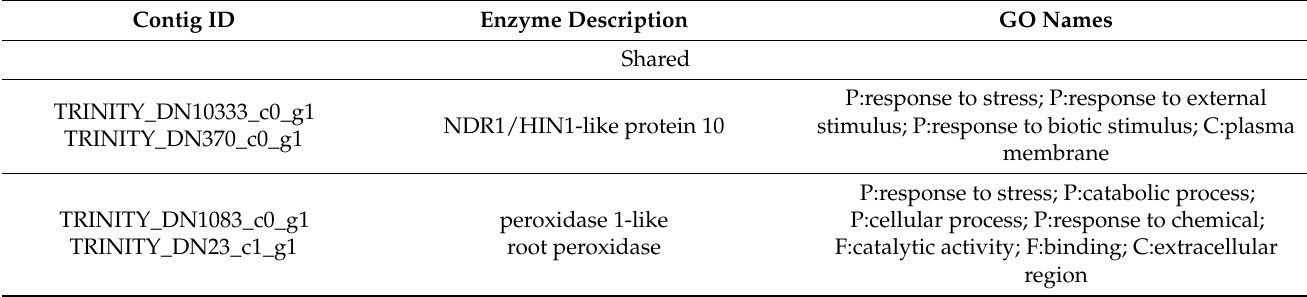
Figure 7. Enriched bar chart of GO names of up-regulated genes as results of pairwise DEGs analysis (Fisher’s exact test). Symbols: ( a ) upregulated GOs of high-dosage treated plants vs. control; ( b ) upregulated GOs of low-dosage treated plants vs. control. Red: treated samples; Blue: control samples. According to these results, contigs of response to stress, response to biotic stimuli, and response to stimulus GO names were further analyzed. Table 2. Up-regulated genes of GO categories Response to stress, Response to biotic stimuli, and Response to stimulus based on Fisher’s exact test. Shared (present in both treated samples) and individual up-regulated genes of high and low dosage treatment of ELICE16INDURES are